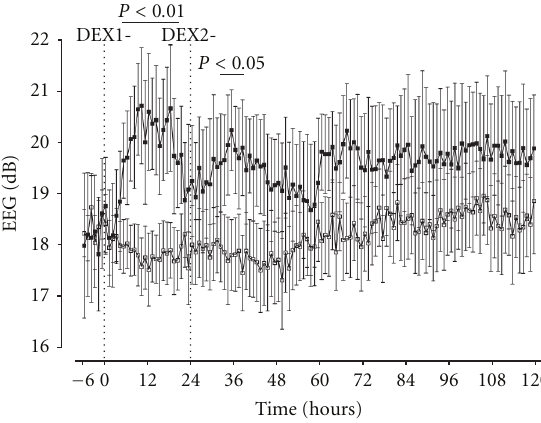
Figure 2: Time course changes in EEG power (dB, decibels) before and after two injections of dexamethasone (filled squares) or saline (open squares) 24 hours apart. The injections for each group are marked by dotted lines (DEX-1 and DEX-2). A significant increase in EEG power was seen after both DEX-1 and DEX- 2, but the e ff ects of DEX were most significant after the first injection. Peak amplitude changes were around 12 hours, and the increase in amplitude was mediated by an overall increase in normal sleep architecture waveforms and the appearance of seizures (see Figure 3). Data are one hour means ± SEM from six hours before until 120 hours after